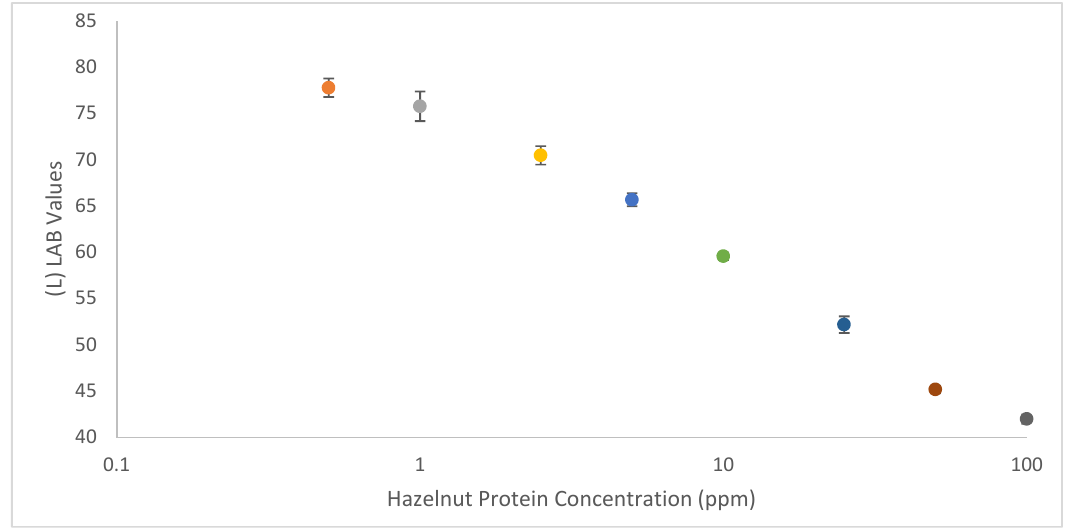
Figure 5. A calibration curve showing the relationship between (L)LAB values of test lines of hazelnut LFIA in a decreasing concentration of hazelnut protein (in blank cookie). Error bars have been included to show the standard deviation across multiple ( n = 3) measurements. An (L)LAB value of 100, (0, 0) corresponds to a true white and of 0 (0,0) to a true black, in this study the lowest L value was 42 and so the L (LAB) axis begins at 40.